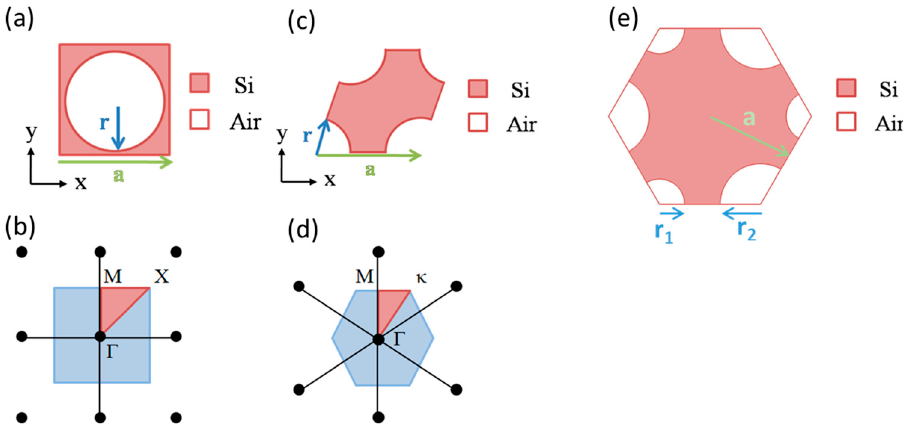
Figure 1. ( a ) Unit cell and ( b ) reciprocal lattice of 2-D square lattice photonic crystals. ( c ) Unit cell and ( d ) reciprocal lattice of 2-D triangular lattice photonic crystals. ( e ) Unit cell of 2-D honeycomb lattice photonic crystals.